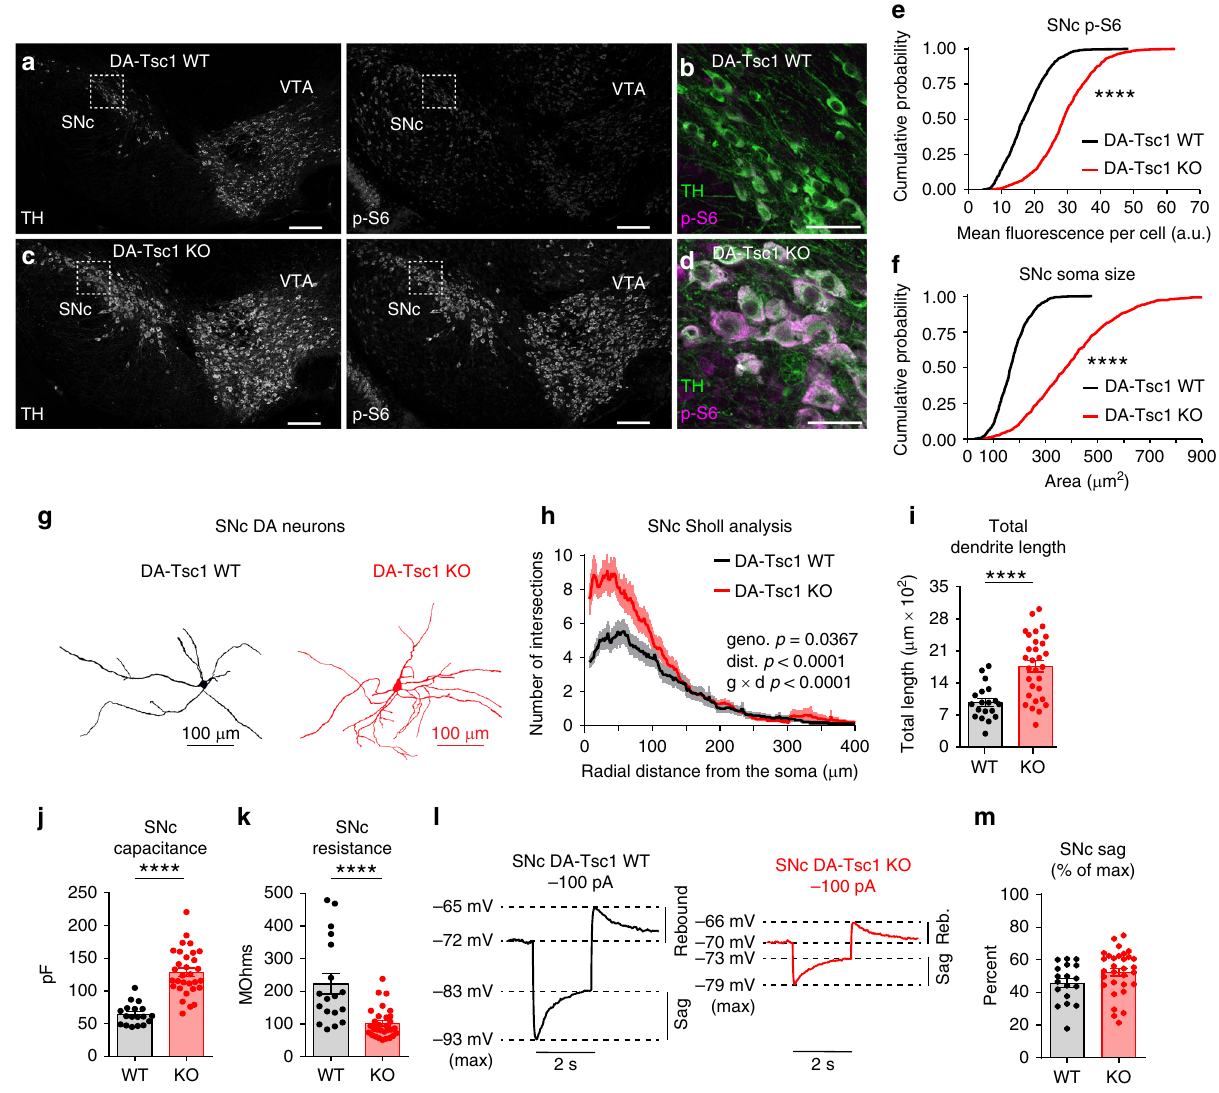
Fig. 1 DA-Tsc1-KO SNc neurons are hypertrophic. a – d Confocal images of midbrain sections from DA-Tsc1-WT ( a , b ) and DA-Tsc1-KO ( c , d ) mice labeled with antibodies against tyrosine hydroxylase (TH) and phosphorylated S6 (p-S6, Ser240/244), scale bars = 200 μ m. b , d show higher magni fi cation merged images of the boxed regions in a , c , scale bars = 50 μ m. e , f Cumulative probability plots of SNc DA neuron p-S6 levels ( e ) and soma area ( f ) (DA-Tsc1 WT: n = 759 neurons from three mice, DA-Tsc1 KO: n = 855 neurons from three mice). **** p < 0.0001, Kolmogorov – Smirnov tests. g Three-dimensional reconstructions of SNc DA neurons. h Sholl analysis of SNc DA neurons. Dark colored lines are the mean, lighter color shading represents SEM (DA-Tsc1 WT: n = 19 neurons from fi ve mice, DA-Tsc1 KO: n = 30 neurons from nine mice). Two-way ANOVA p values are shown. i Mean± SEM total dendritic length per cell (DA-Tsc1 WT: n = 19 neurons from fi ve mice, DA-Tsc1 KO: n = 30 neurons from nine mice). **** p < 0.0001, Welch ’ s two-tailed t test. j , k Mean ± SEM membrane capacitance ( j ), and membrane resistance ( k ) (DA-Tsc1 WT: n = 18 neurons from fi ve mice, DA-Tsc1 KO: n = 31 neurons from nine mice). **** p < 0.0001, Welch ’ s two-tailed t test ( j ) or Mann – Whitney test ( k ). l Example current-clamp recordings from SNc DA neurons in response to a − 100 pA current step. m Mean ± SEM sag amplitude expressed as a percentage of the maximum hyperpolarization from baseline (DA-Tsc1 WT: n = 18 neurons from fi ve mice, DA-Tsc1 KO: n = 31 neurons from nine mice). p = 0.0941, unpaired two-tailed t test. For all bar graphs, dots represent values for individual neurons. See also Supplementary Fig. 1 and Supplementary Tables 1 and 2. Source data are provided as a Source Data fi Tsc1 loss impairs striatal DA release . The AP fi ring of DA